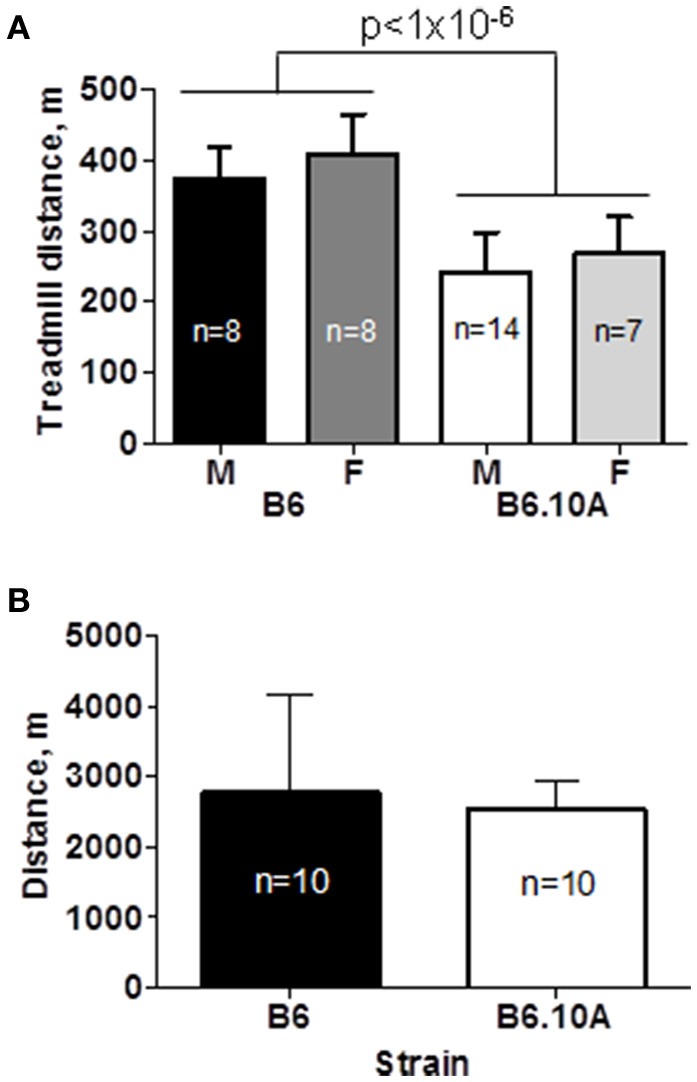
Chromosome 10 of the A/J strain confers lower endurance capacity. (A) Forced treadmill running distance of the consomic B6.A10 strain was reduced compared to the host C57BL/6 (B6) strain. Males (M) and females (F) were similarly affected. (B) Voluntary wheel running distance over 24 h period was not different between males of the two strains. Mean and SD shown; n indicates number of animals per group; p-value for weight adjusted strain effect is shown.